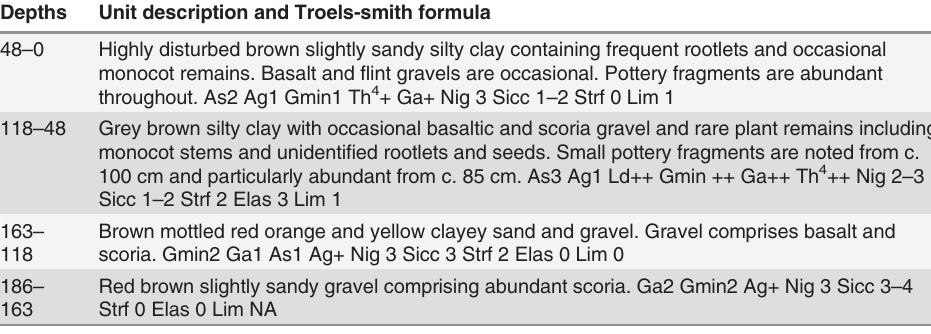
Table 3. Lithostratigraphy of the